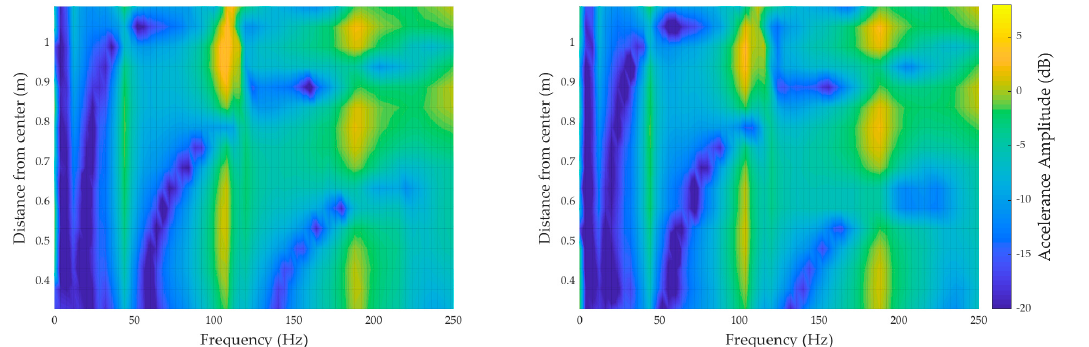
Figure 6. Accelerance maps of a Rossignol Dualtec Generation 210: ( left ) without VAS; ( right ) with